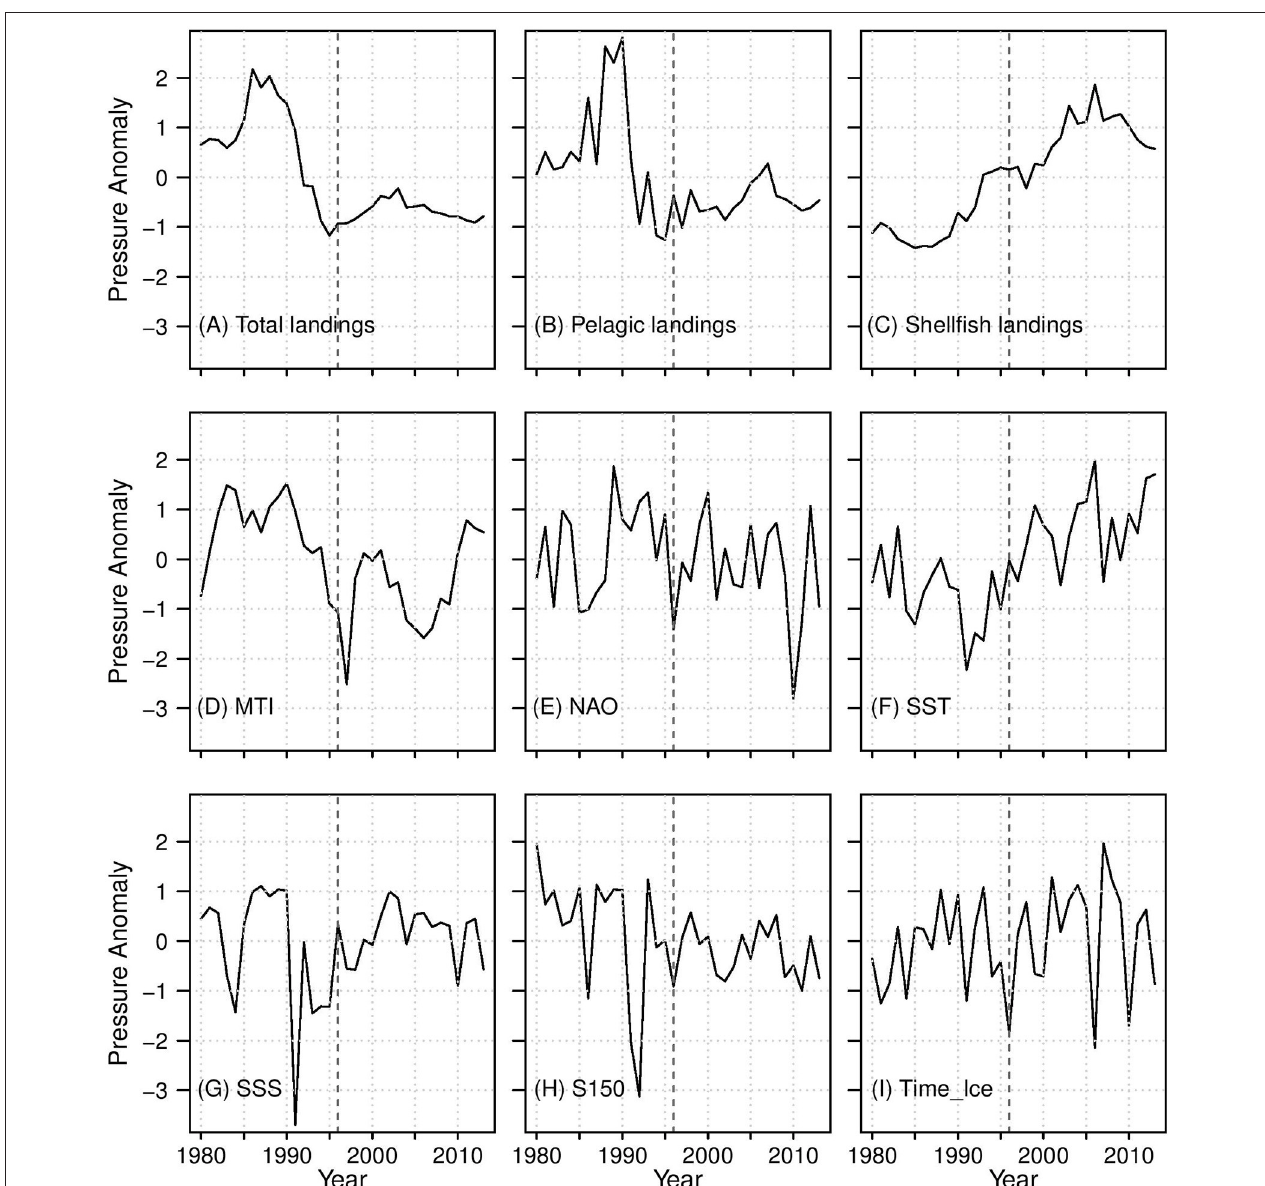
FIGURE 3 | Pressure indicators used as predictors in this analysis. Fishing indicators: (A–D) ; Environmental indicators: (E–I) . The thick dashed line indicates the beginning of the After